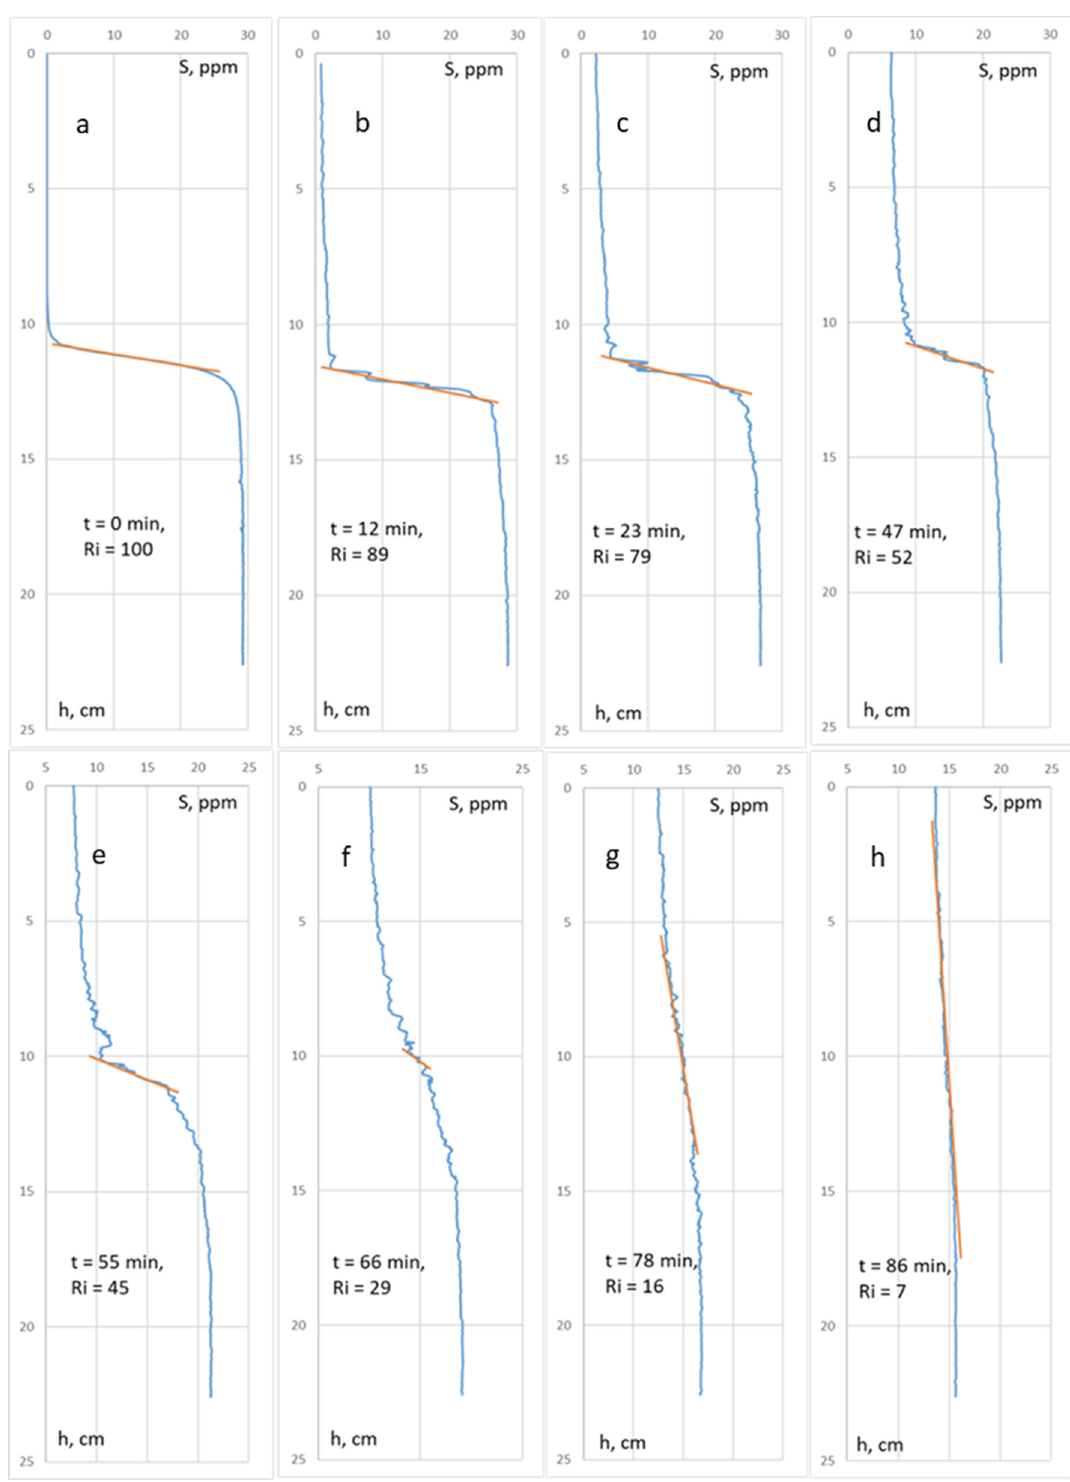
Figure 4. The sequence of salinity profiles measured during one of the experimental runs with initial conditions as follows: ∆ S initial = 30 ppm, Ri initial = 100, and Re = 214. Tangent lines (marked in orange) are added to the quasi-linear sections of the profiles with the maximum salinity gradient. The subfigures are shown during the experimental run at the time and the Richardson number as follows: ( a ): t = 0 min, Ri = 100; ( b ) t = 12 min, Ri = 89; ( c ) t = 23 min, Ri = 79; ( d ) t = 47 min, Ri = 52; ( e ) t = 55 min, Ri = 45; ( f ) t = 66 min, Ri = 29; ( g ) t = 78 min, Ri = 16; ( h ) t = 86 min, Ri =